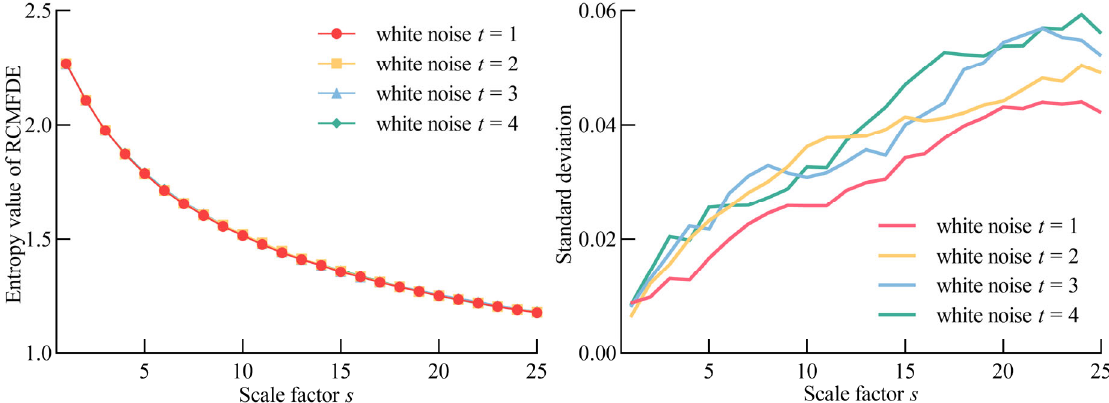
Figure 6. Effect of parameter t on RCMFDE.